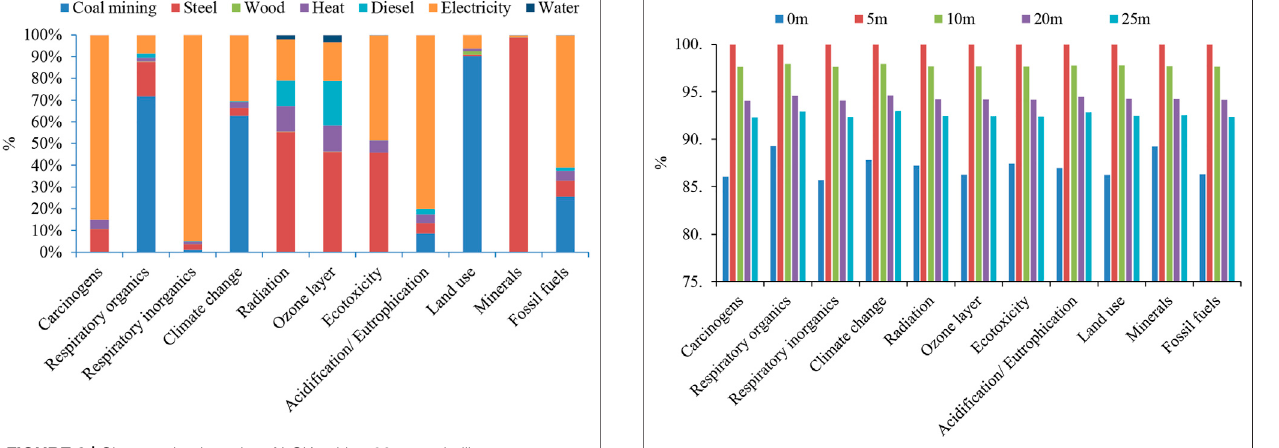
FIGURE 3 | Characterized results of LCIA taking 20 m coal pillar as an example. FIGURE 4 | Characterized results of LCIA (overall